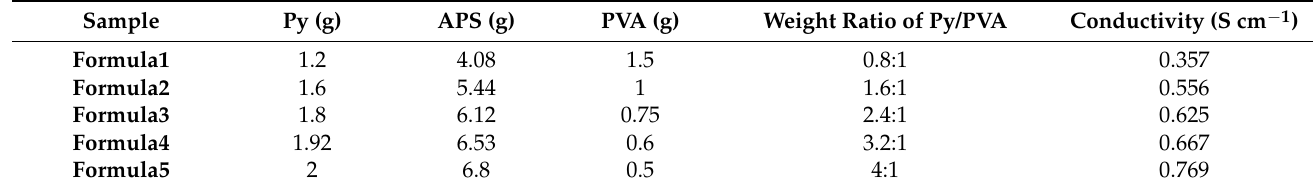
Table 2. Conductivity of PPy/CNCs varies with the Py/PVA weight